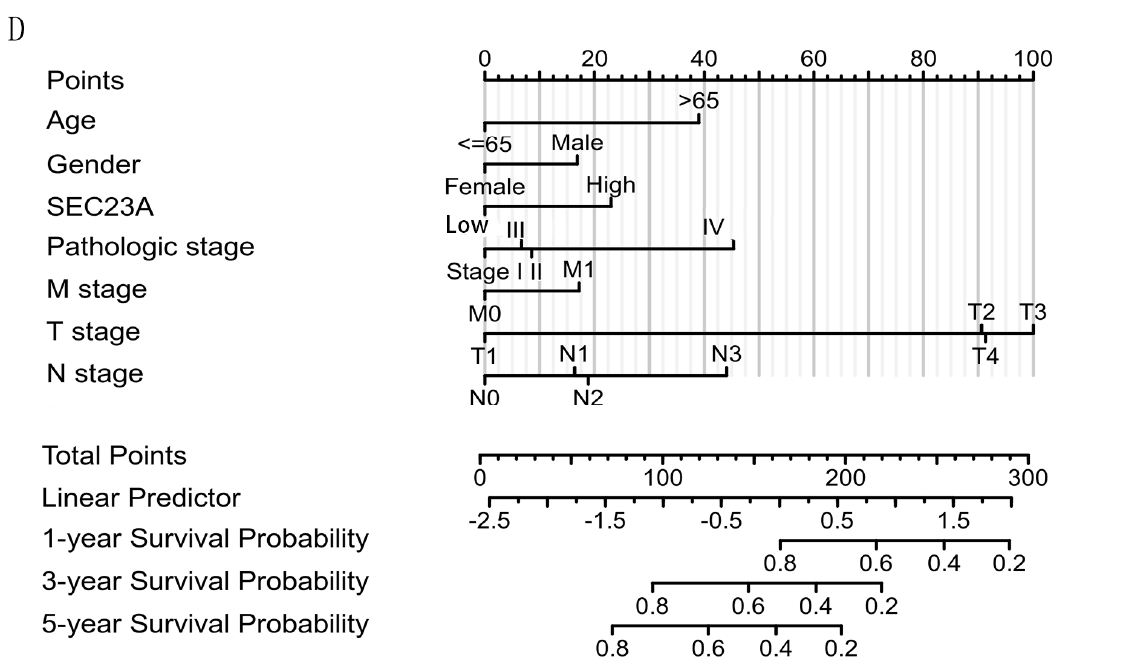
Figure 3. Association between SEC23A expression and prognosis. Increased SEC23A expression in STAD is associated with worse DSS ( A ), not with PFI ( B ) but again with worse OS ( C ). Multivariate Cox analysis of SEC23A expression and other clinicopathological factors ( D ). Points: for the single scores, they correspond to each predicted variable. Total Points: sum of the single score points. Linear Predictor: weighted sum of the variables in the Cox regression model with high values indicative of a worse prognosis. Table 1. Cox regression analysis for OS.